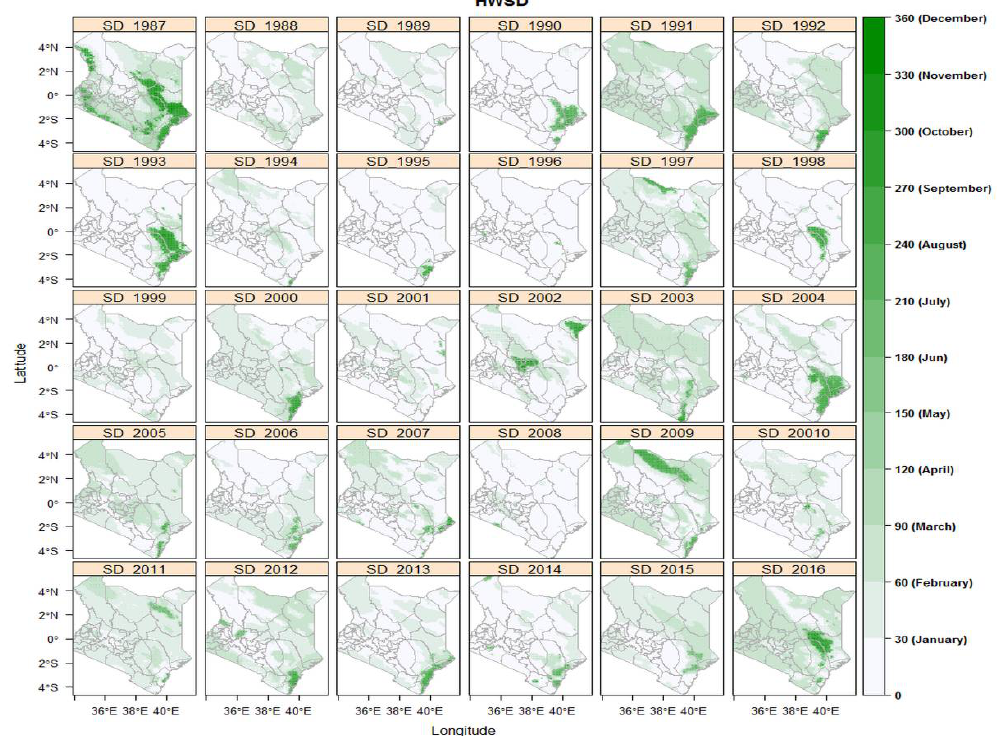
Figure 4. Starting dates of heatwaves events of Figure 2 in nth days 1987–2016. The white (0) indicates no heatwave event .